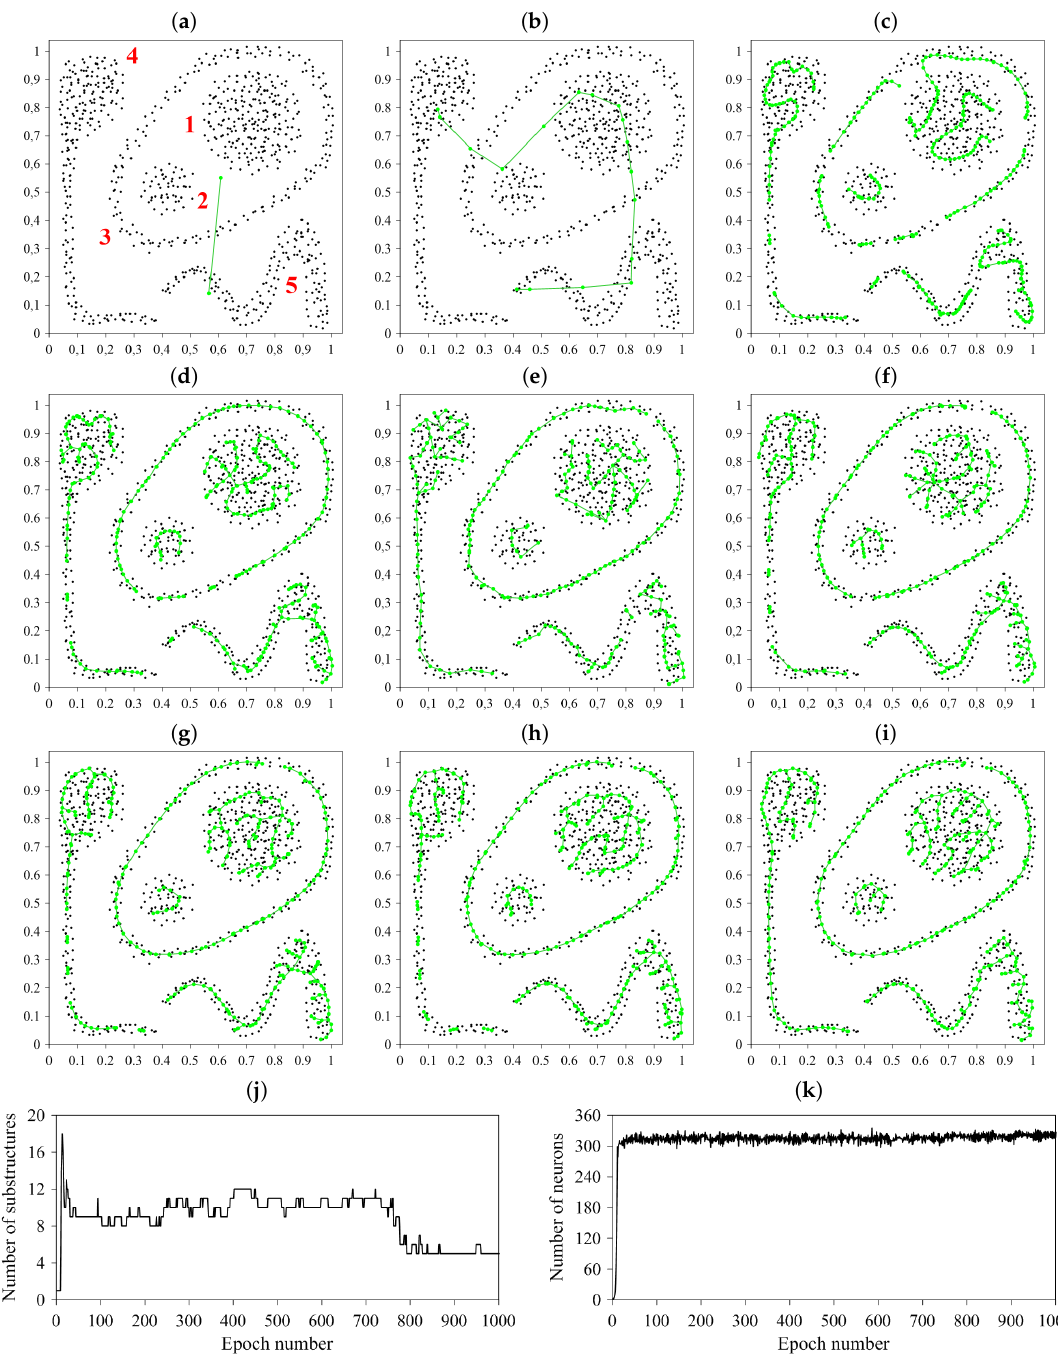
Figure 18. The evolution of GeSOM with T-LSs in the synthetic data set of Figure 6a in learning epochs: ( a ) No. 0 (start of learning), ( b ) No. 5, ( c ) No. 10, ( d ) No. 20, ( e ) No. 50, ( f ) No. 100, ( g ) No. 300, ( h ) No. 500, and ( i ) No. 1000 (end of learning) as well as plots of the number of substructures ( j ) and the number of neurons ( k ) vs. epoch